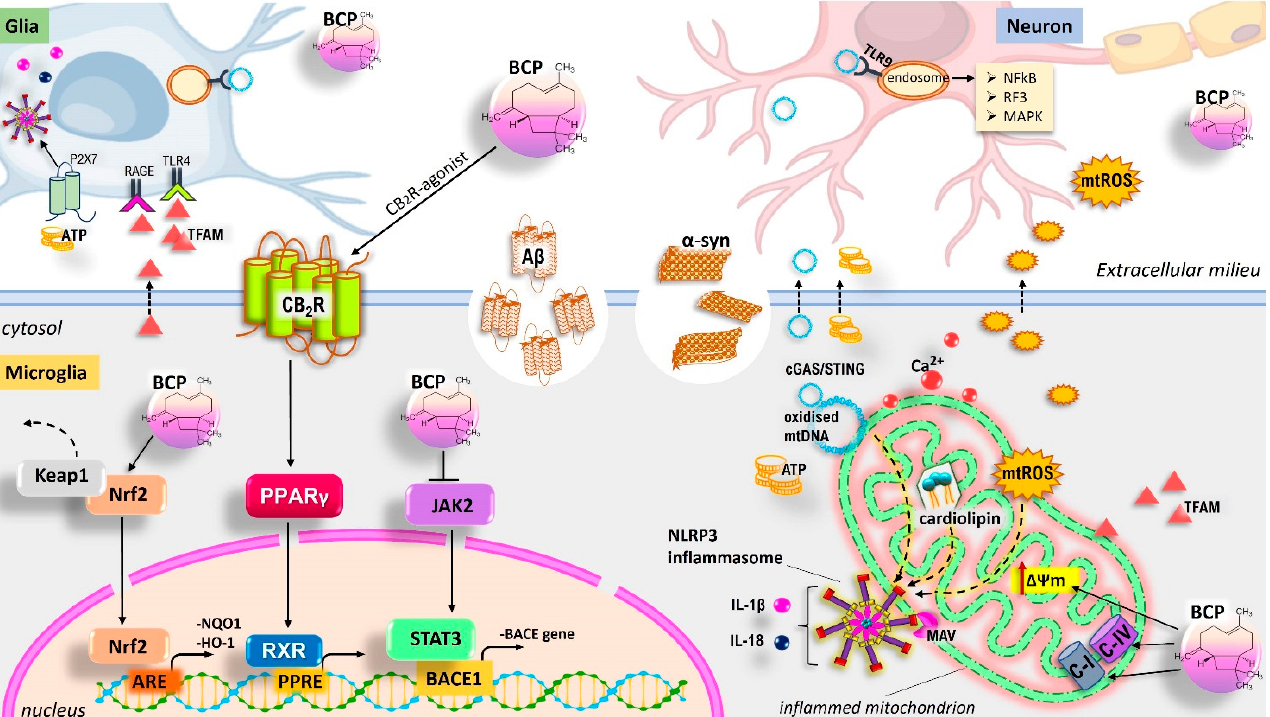
Figure 4. Current model of multi-target protective effects of β -caryophillene (BCP) at the intersection of mitochondrial dysfunction, neuroinflammation, and neurodegeneration. Upon stressful conditions, including oxidative injury, accumulation of altered/misfolded proteins, and inflammatory stimuli, mitochondria are impaired with the ensuing release of mtDAMPs such as ROS, Ca 2+ , oxidized mtDNA, cardiolipin, ATP, and TFAM. In surrounding neurons and glial cells, mtDAMPs bind to TLR9, the purinergic P2X7 receptor, RAGE, and TLR, promoting further mitochondrial damage and triggering pro-inflammatory, pro-apoptotic cascades that contribute to exacerbation of proinflammatory microglial activation, with the consequent degeneration of dopaminergic neurons. BCP provides neuroprotective effects, decreasing oxidative stress by upregulating antioxidant defence, reducing the expression of proinflammatory cytokines by inhibiting the NF κ B pathway, and preserving mitochondrial function upregulating respiratory enzyme complex (I–IV) activities. Therefore, Keap1 degradation and Nrf2/HO-1/NQO1 signalling pathway activation, upregulation of the CB2R/PPAR γ axis, and inhibition of the “JAK2-STAT3-BACE1” signalling pathway suppress TLR4, NO, PGE2, iNOS, and COX-2 expression, the secretion of pro-inflammatory cytokines, as well as A β oligomerization and deposition.